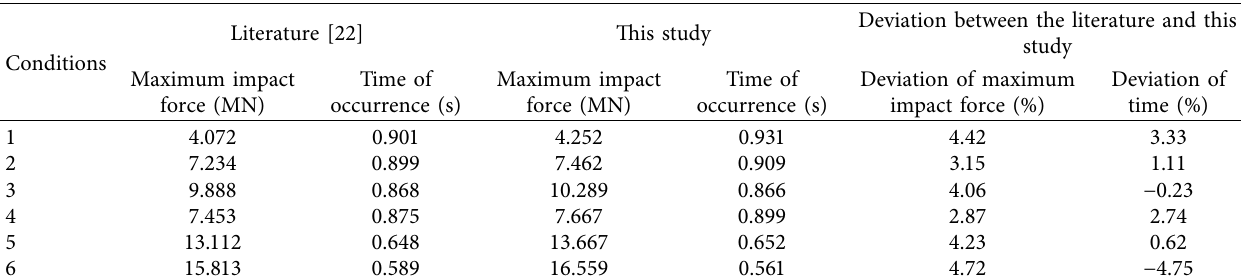
Table 6: Comparison table for calculating